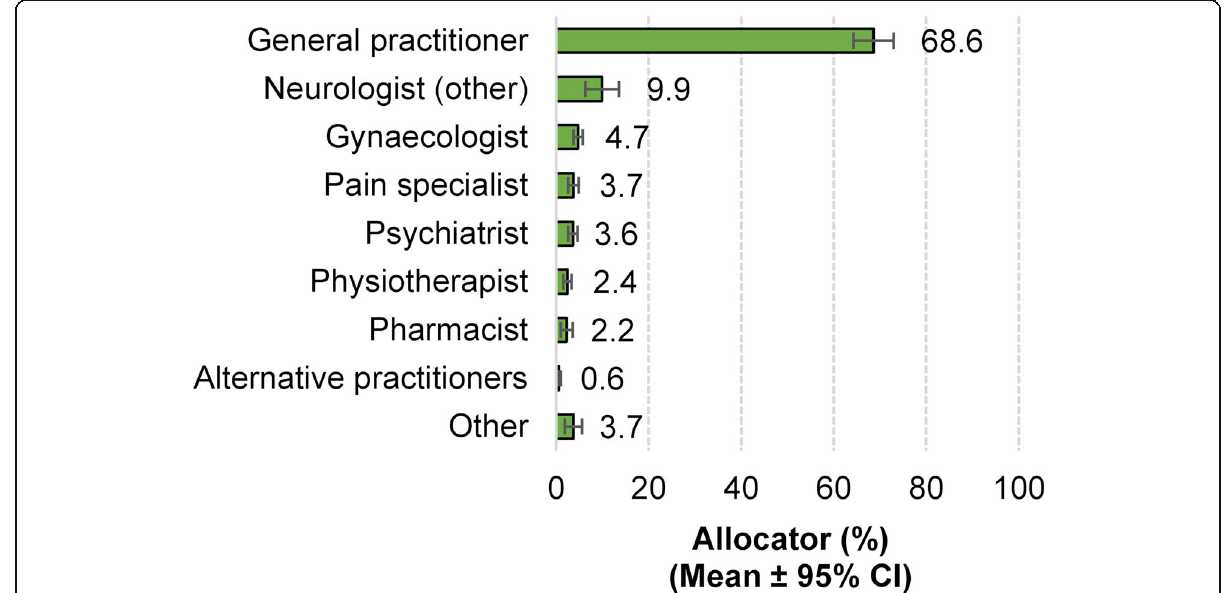
Fig. 2 Referral of patients to headache specialists by type of physician or health care